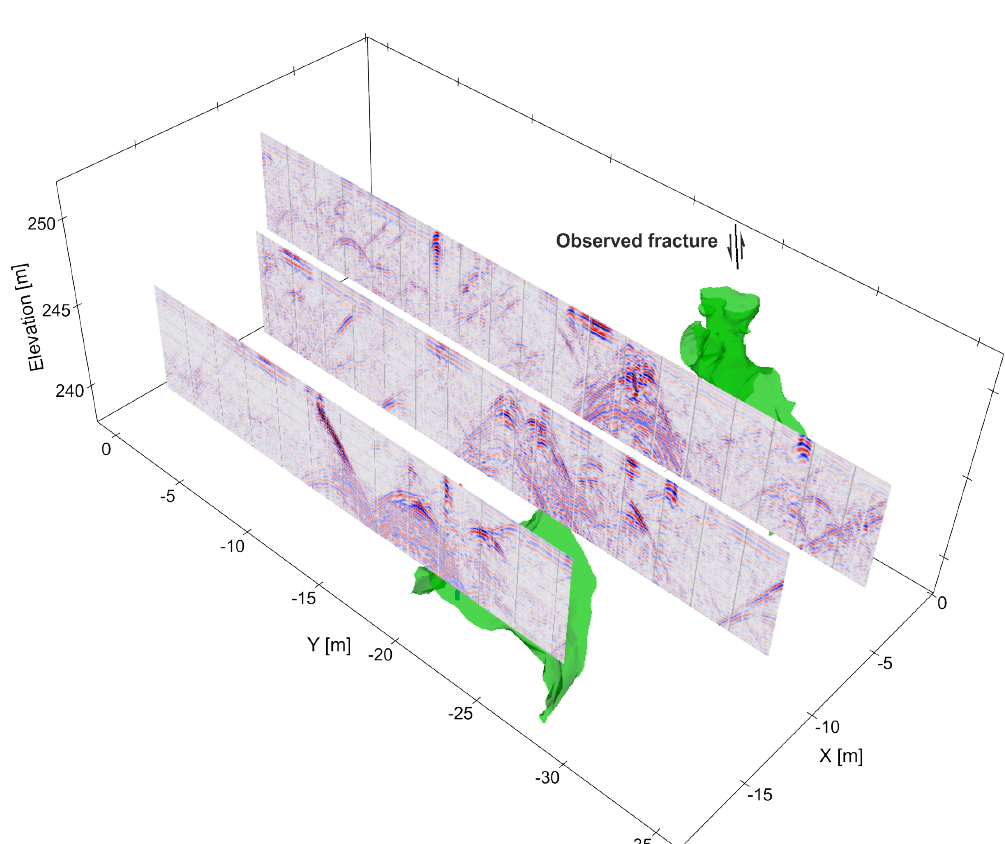
Figure 10. 200 MHz GPR data acquired prior to the ERT survey, showing high amplitude reflections at the location of the imaged void and related fracture. The processing flow comprised system gain removal, background removal, band-pass filtering, and application of a gain